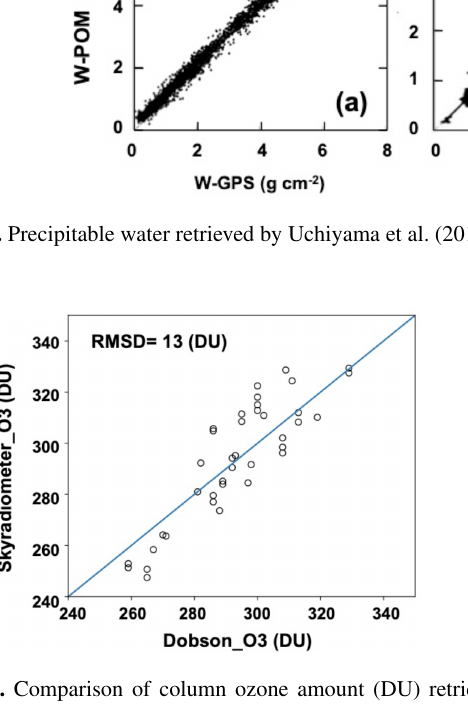
Figure 12. Comparison of column ozone amount (DU) retrieved from the sky radiometer at MRI Tsukuba site and from Dobson spectrometer at the JMA Tateno Observatory from 13 December 2012 to 8 January 2013.